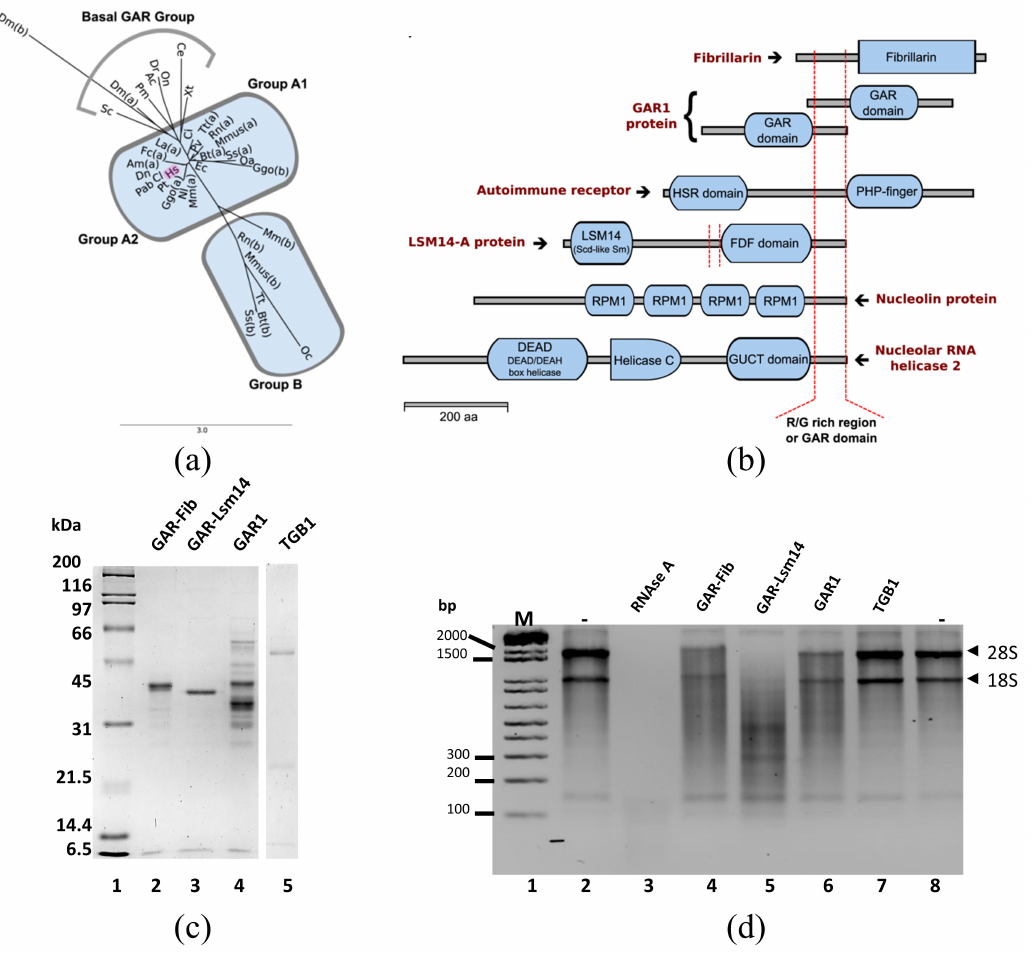
Figure 6. RNA activity of GAR domains from di ff erent RNA-binding proteins. ( a ) Bioinformatic analysis of R / G rich region (or GAR domain) of retrieved proteins from 36 complete genomes. The phylogenetic tree of GAR domains of fibrillarin proteins was retrieved from chordates genome data. GAR domains were clustered in three major clades: A, B, and the basal group. Clade A was divided into A1 and A2 subgroups. ( b ) Schematic representation of di ff erent modular proteins shows the presence of GAR domains in N- or C-terminal regions. Five proteins contained GAR domains similar to fibrillarin: GAR1 protein, an autoimmune receptor, Lsm14, Nucleolin, and a nucleolar RNA helicase 2. ( c ) IMAC a ffi nity purification of GAR domains from fibrillarin, Lsm14, GAR1, and viral protein TGB1 with a disordered domain similar to GAR. ( d ) In vitro RNA assay of four GAR domains expressed and purified from E. coli. TGB1 and GAR1 (Lanes 6 and 7) showed no activity against total RNA. RNAse A diluted 1:20,000 was used as